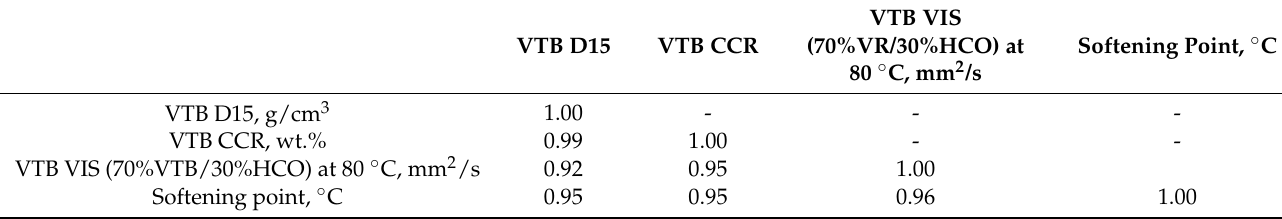
Table 4. 1 µ -value of ICrA for the evaluation of relations of H-Oil ® VTB properties density, Concarbon content (CCR), kinematic viscosity of blends 70%VTB/30%FCC HCO, and softening point.